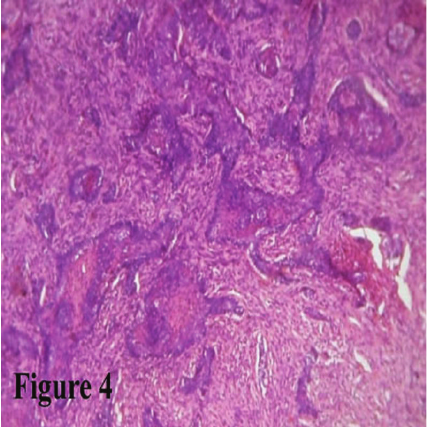
Figure 1: Swelling at lingual alveolar mucosa of the mandibular 32– 34 regions.